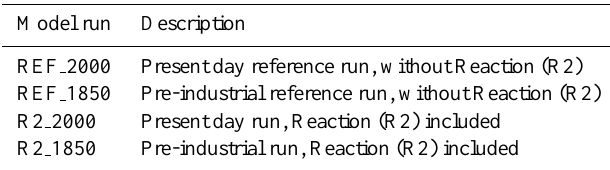
Table 1. The model runs carried out in this